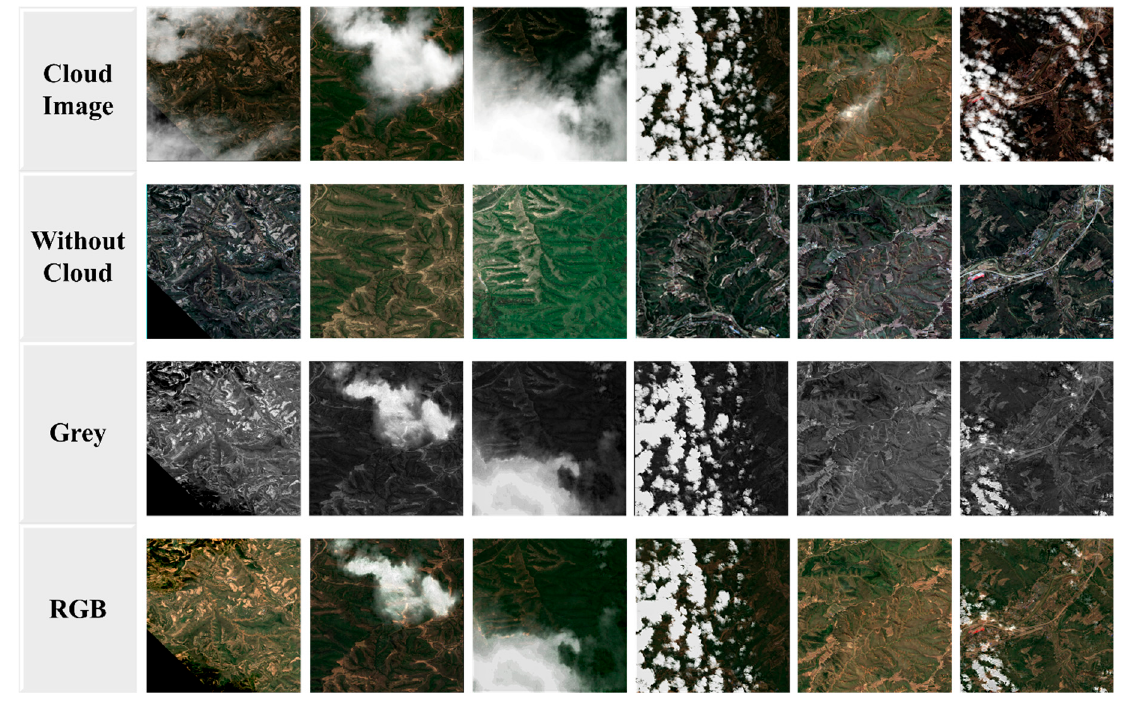
Figure 7. Comparison of estimated cloud transparency images.